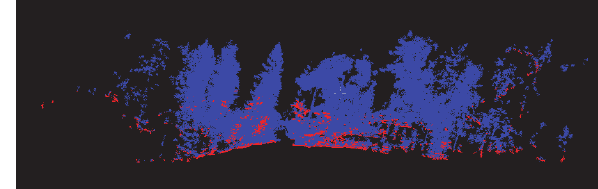
Figure 3. The LasTools classification of ground points (red points) resulted in some misclassified points belonging to the vegetation.